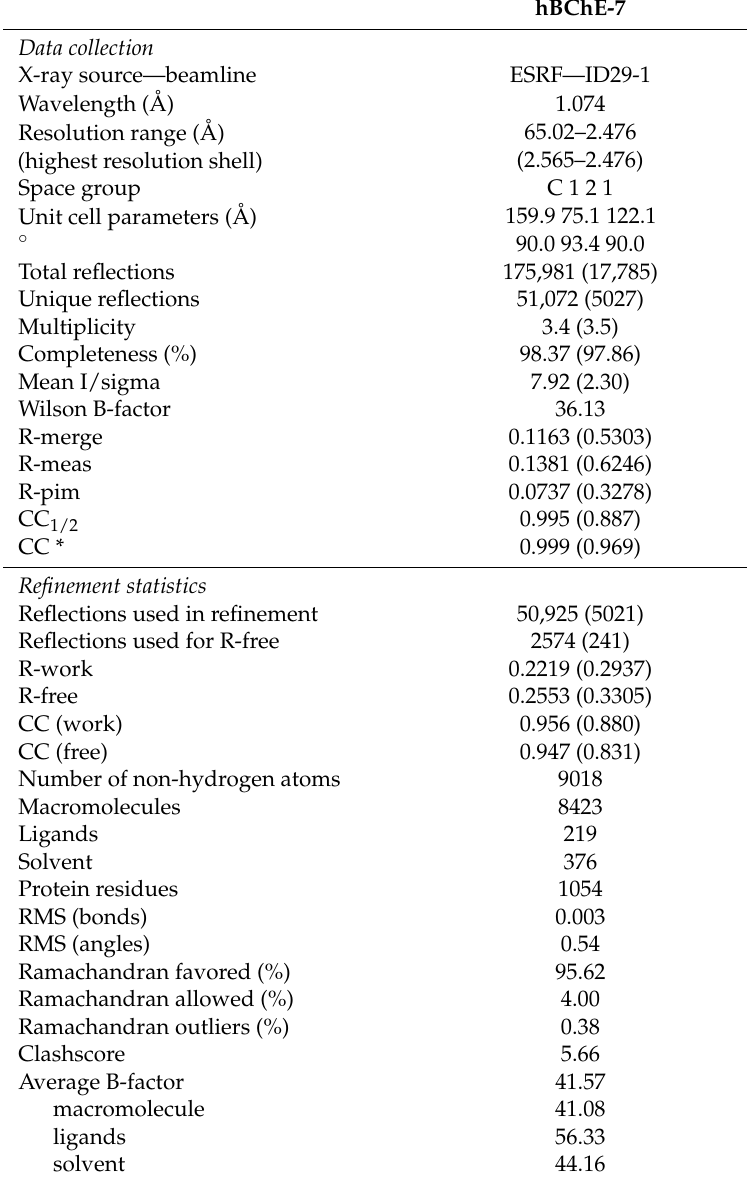
Table 4. X-ray data collection and refinement statistics for hBChE-7 structure. R-work = Σ | F o | − | F c |/ Σ | F o |, F o and F c are observed and calculated structure factors, R-free set uses 5% of randomly chosen reflections. Statistics for the highest-resolution shell are shown in